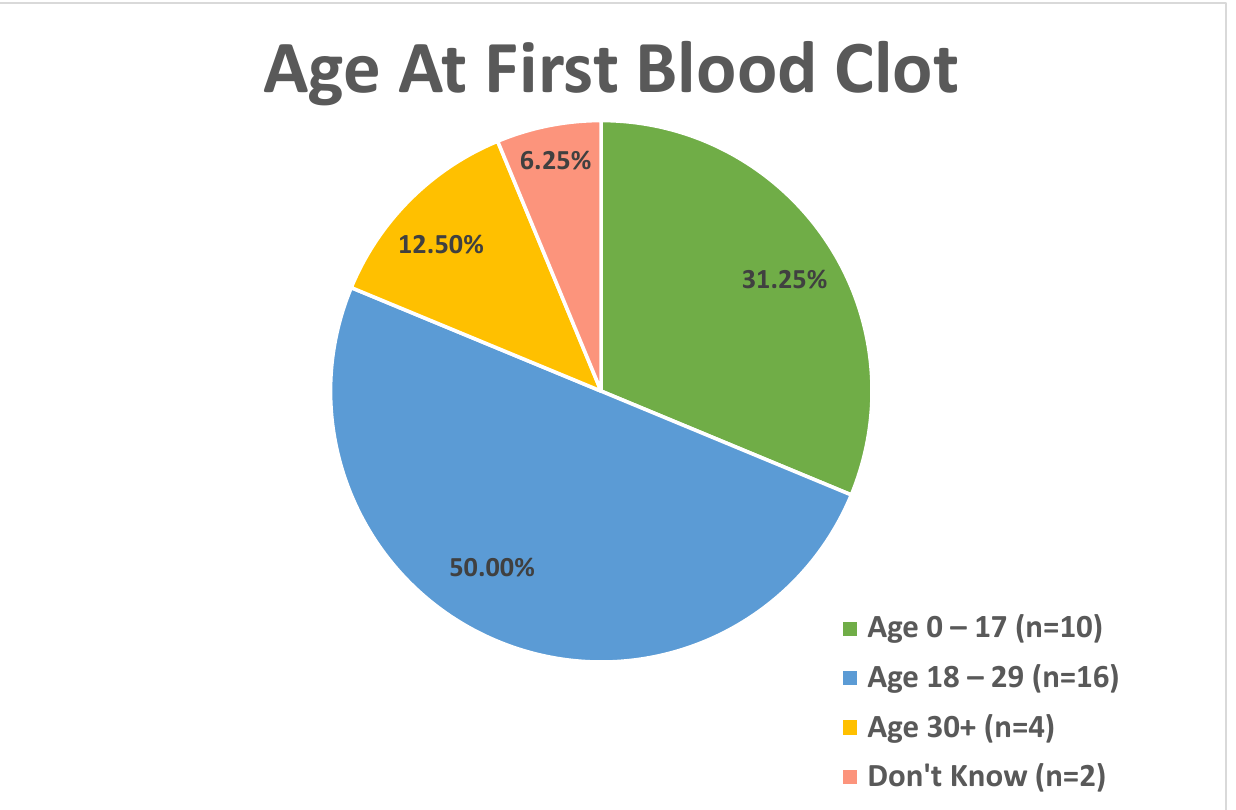
Figure 2. Age at first blood clot in PWS participants who reported a blood clot in the Thrombosis History Survey.